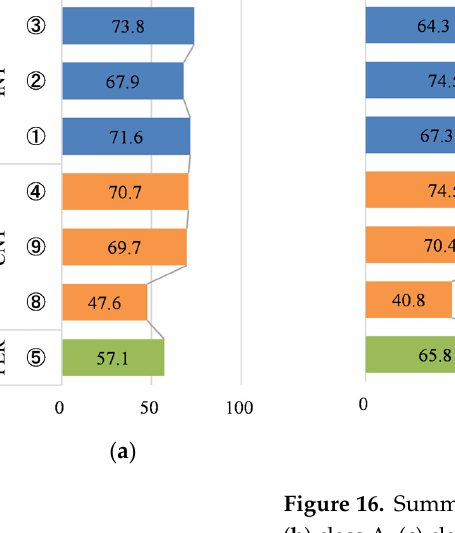
Figure 15. Summer comfort range percentage based on the JSEHMS for the ( a ) total average and in ( b ) class A, ( c ) class B, and ( d ) class C.